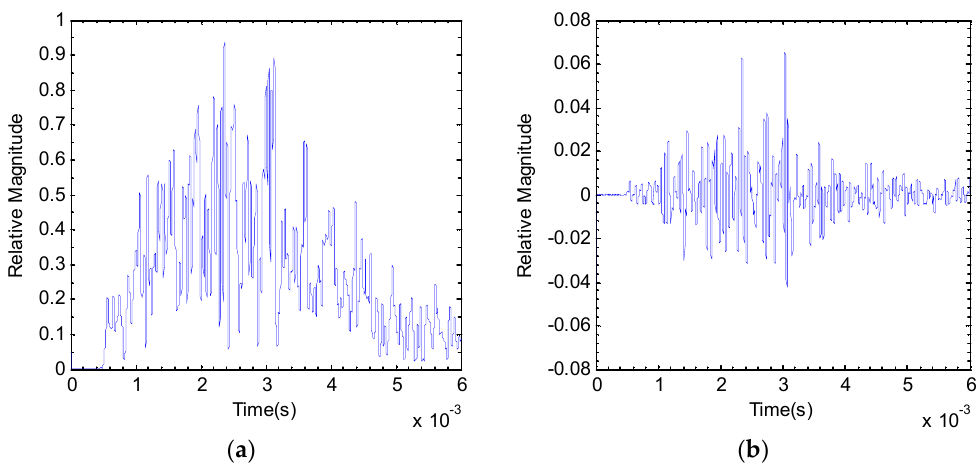
Figure 7. ( a ) Echo envelope with LFM 40–80 kHz frequency; ( b ) gradient of the echo envelope from ( a ).